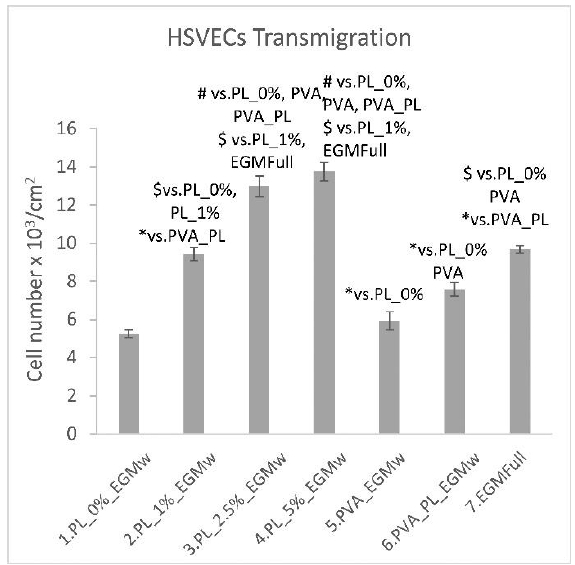
Figure 9. Transmigration assay of the HSVECs toward the EGMw medium, and the EGMw supplemented with 1, 2.5 and 5% of PL, with PVA nanofibers, and with PVA–PL nanofibers, and toward the EGM-full medium at 4 h following seeding. The data are presented as the mean ± S.D. from 3 samples, # refers to p < 0.001, $ to p < 0.01, * to p < 0.05.